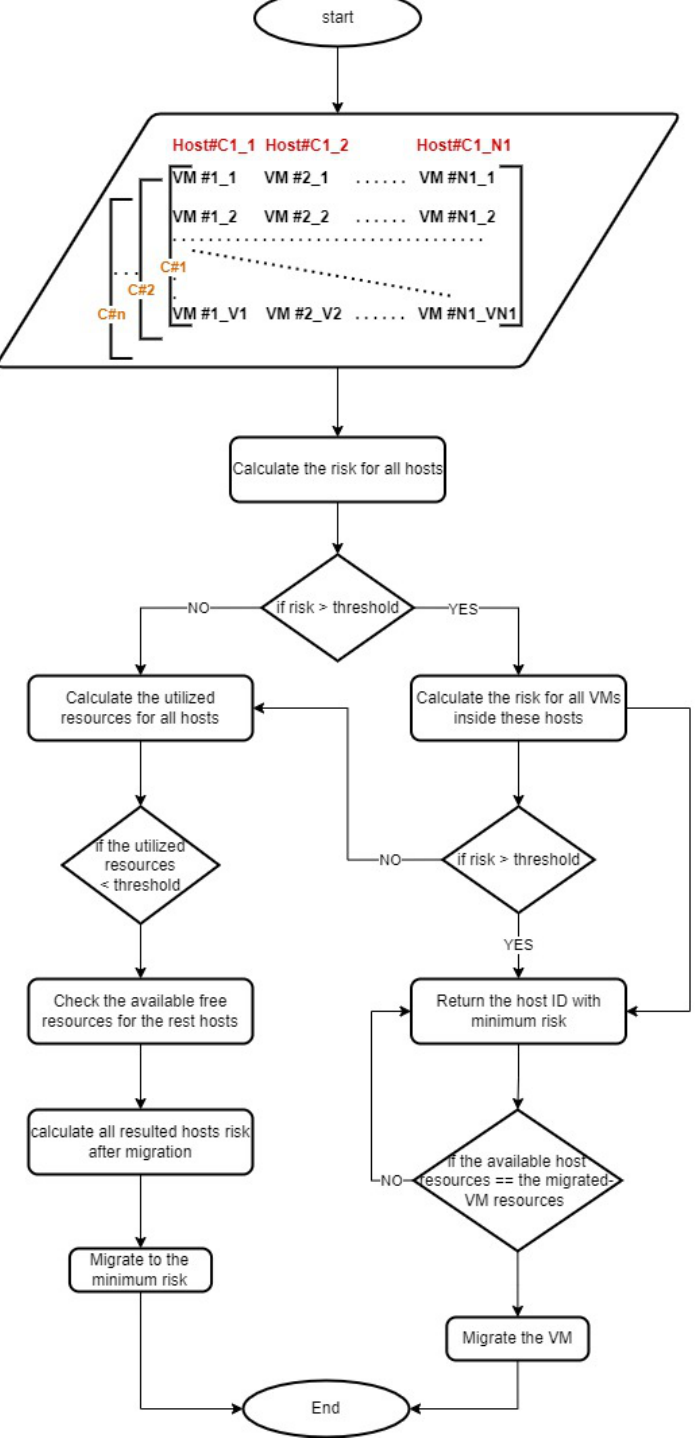
Figure 2. Deployment and migration flow